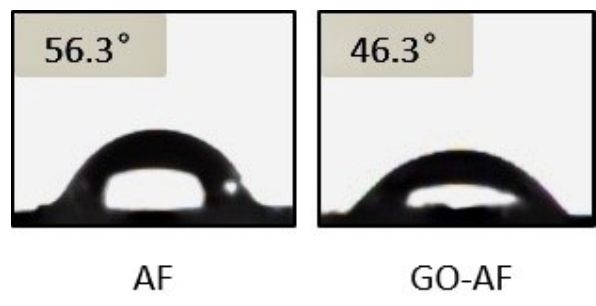
Figure 12: Water contact angle of AF and GO-AFs